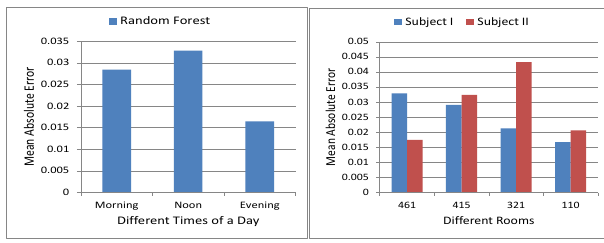
Figure 22: Location estima- tion error in different rooms with different occupancy